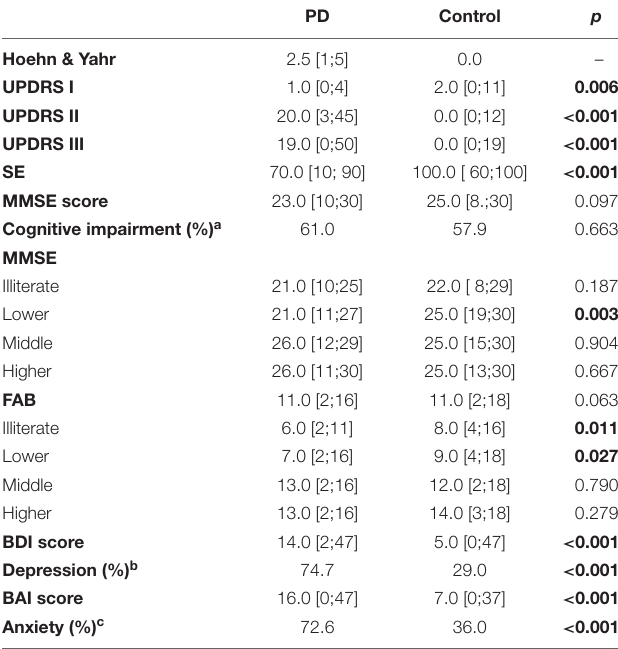
TABLE 2 | Clinical assessment scores of Pakinson’s disease (PD) patients and